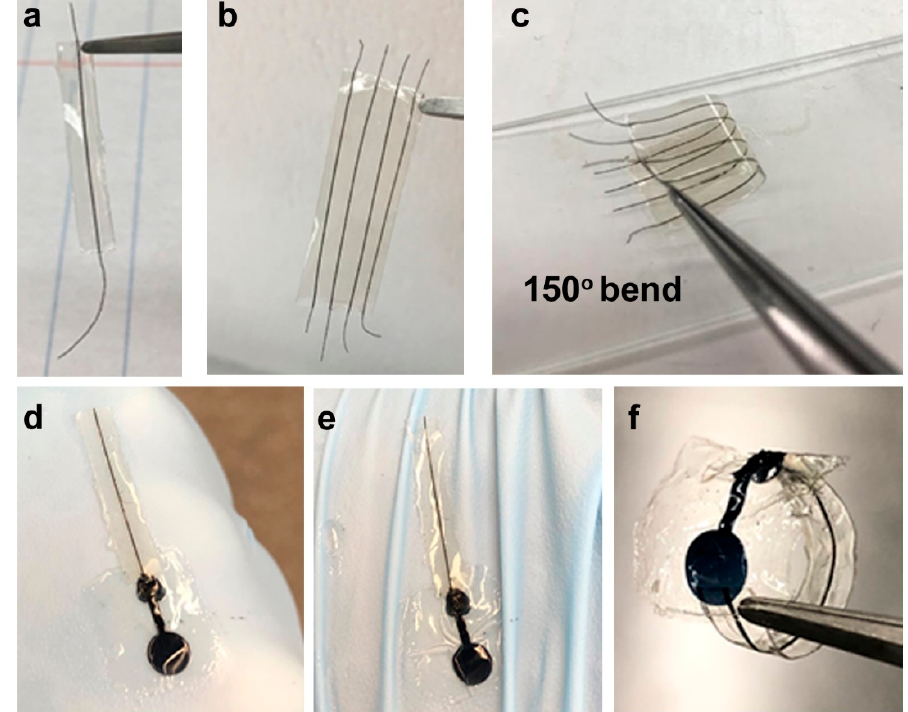
Figure 4. ( a ) Single and ( b ) multiple fibers can be sheathed using this technique, allowing for potentially multiplexed biosensors. ( c ) The PEDOT:PSS fibers are stable to bending in the sheaths. ( d ) Integrated wire and flexible biosensor. The microfabricated electrode biosensor is formed from an organic conducting ink and is connected to the wires to form a functional device. ( e ) The mechanically flexible device can conform to irregular surfaces. ( f ) Bending without breakage.